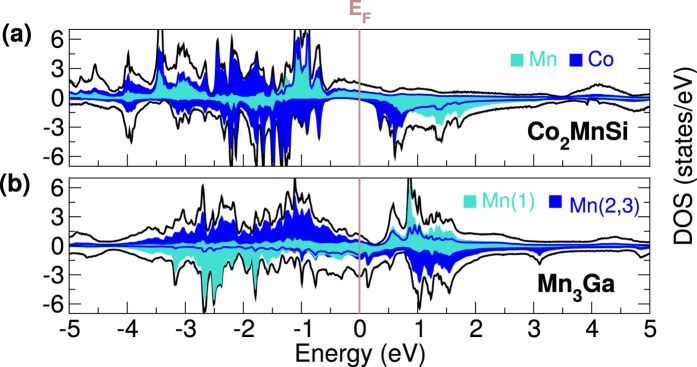
The spin resolved total density of states (in states/eV) for (a) Co2MnSi and (b) Mn3Ga. In each case the contribution of the Co and Mn d-states are given by the filled area.